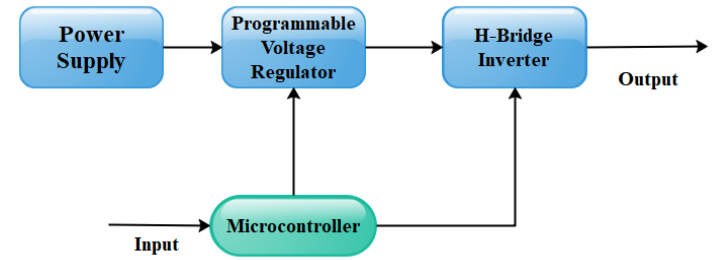
Figure 50. Block diagram for concept of MLI using LM350.